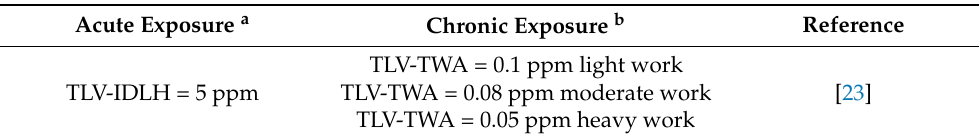
Table 3. Occupational limits for acute and chronic exposure to ozone defined by the National Institute for Occupational Safety and Health